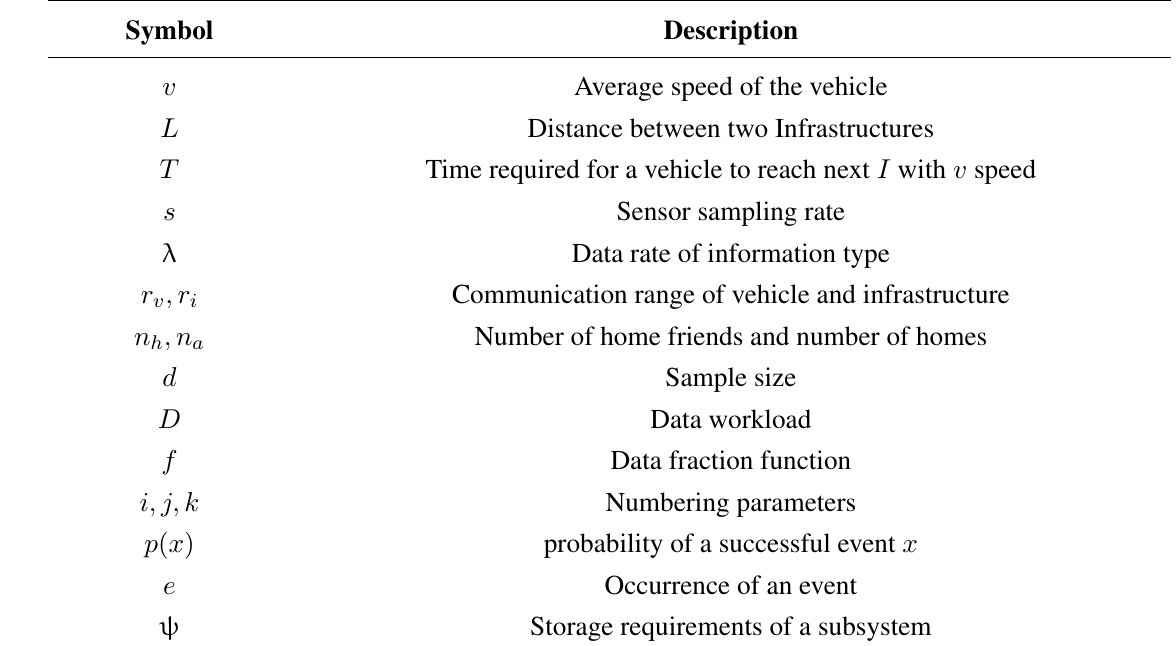
Table 1. List of